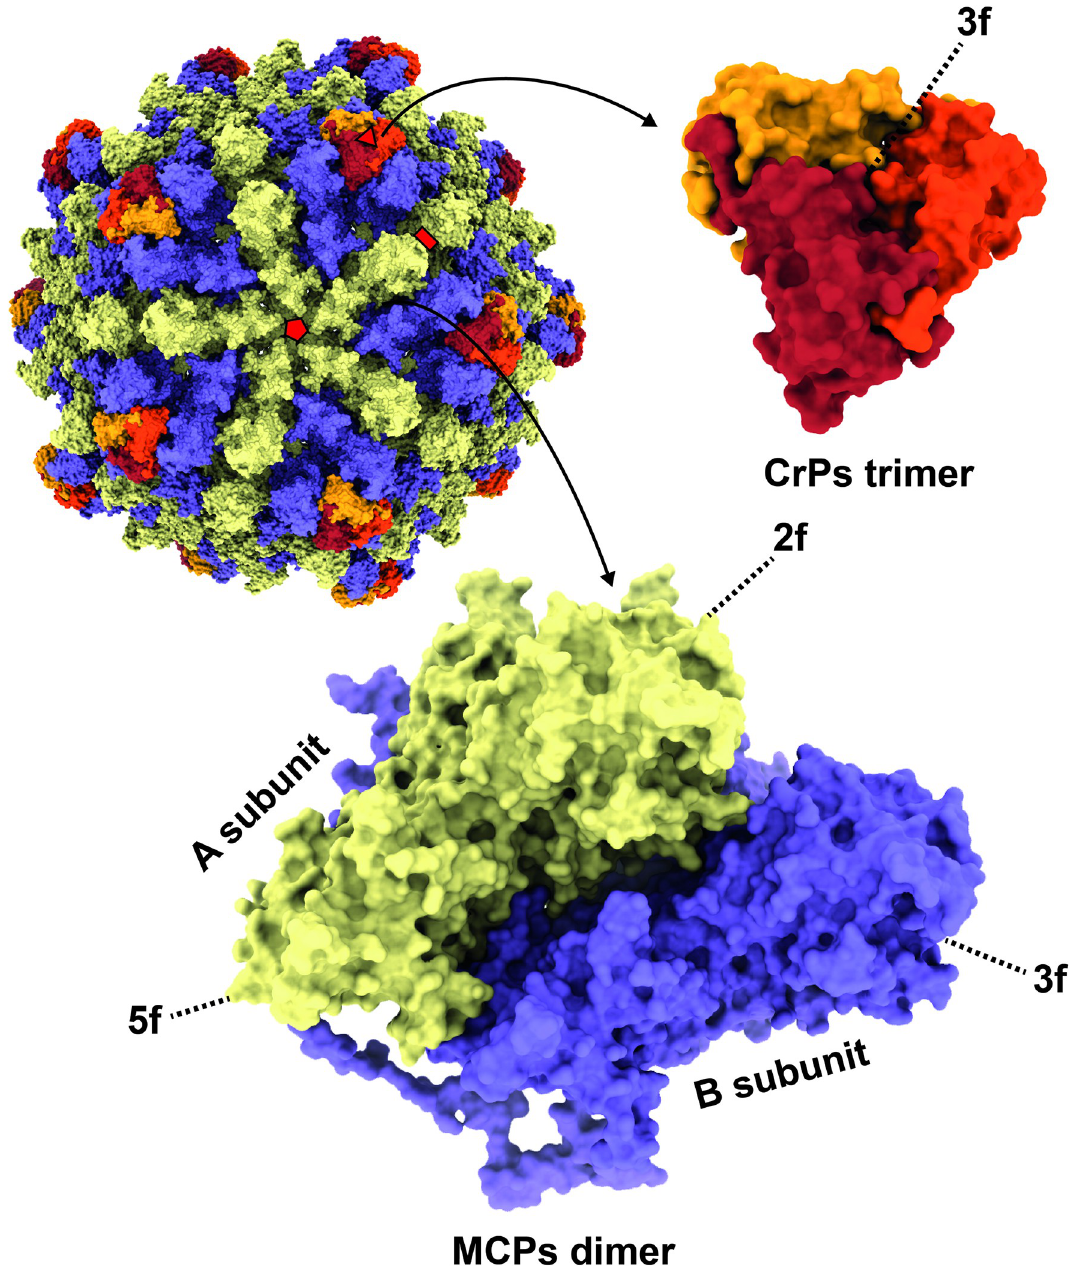
Fig 1. Overall capsid structure of RnMBV1. The RnMBV1 capsid comprises 60 MCP dimers (yellow: MCP_A, purple: MCP_B) and the CrP timers (in red, orange, and dark yellow). The red pentagon, triangle, and rectangle show the icosahedral 5-fold (5f), 3-fold (3f), and 2-fold (2f) axes,